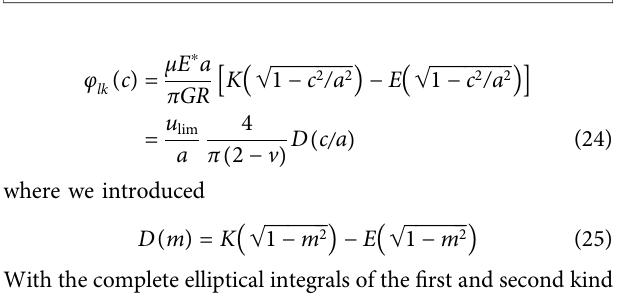
FIGURE 6 | Dependency of the macroscopic coef fi cient of friction (forward) on the dimensionless velocity and oscillation amplitude for bore oscillations acting on a Hertzian Indenter. The smallest value of ~ v 0 is 0.005. Red curve represents the limiting solution according to Eq. 29 green curve represents (33)